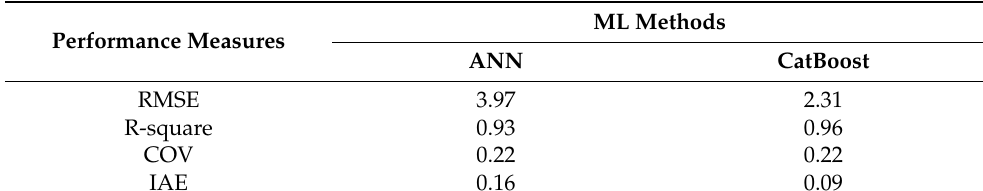
Table 4. Performance comparison of ANN and CatBoost.